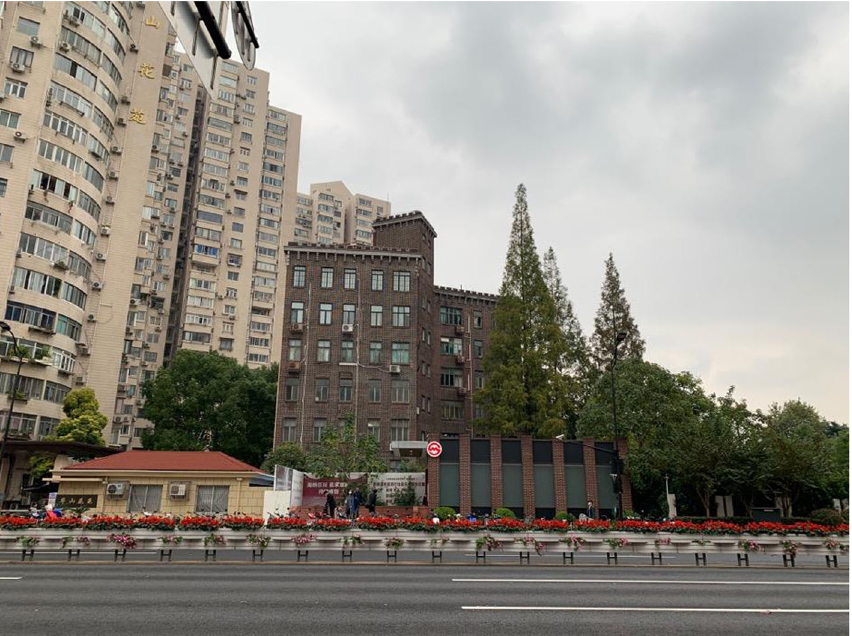
Fig. 4 Entrance to Jiao Tong University Metro Station (metro lines 10 – 11) with Houston Court apartments in the background. (Source: the author)